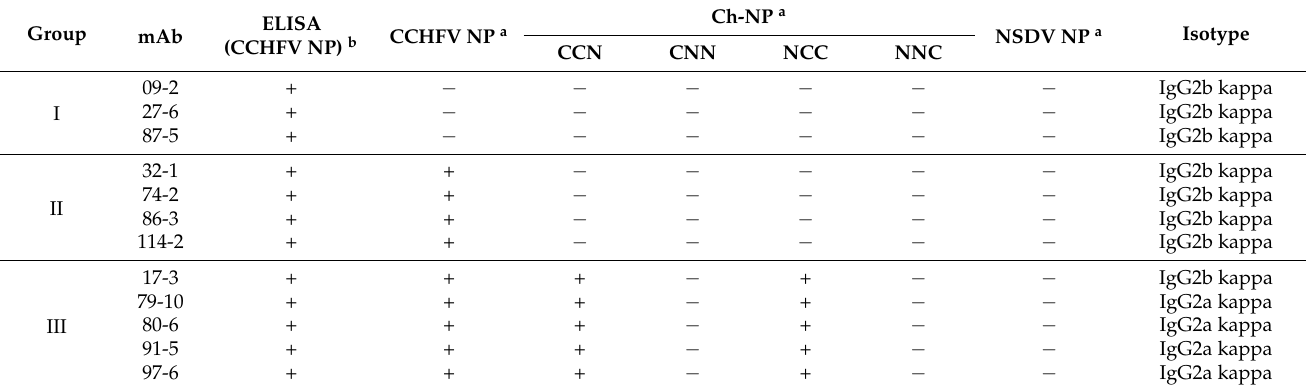
Table 2. Classification of mouse anti-CCHFV NP mAbs based on their reactivities in Western blotting.